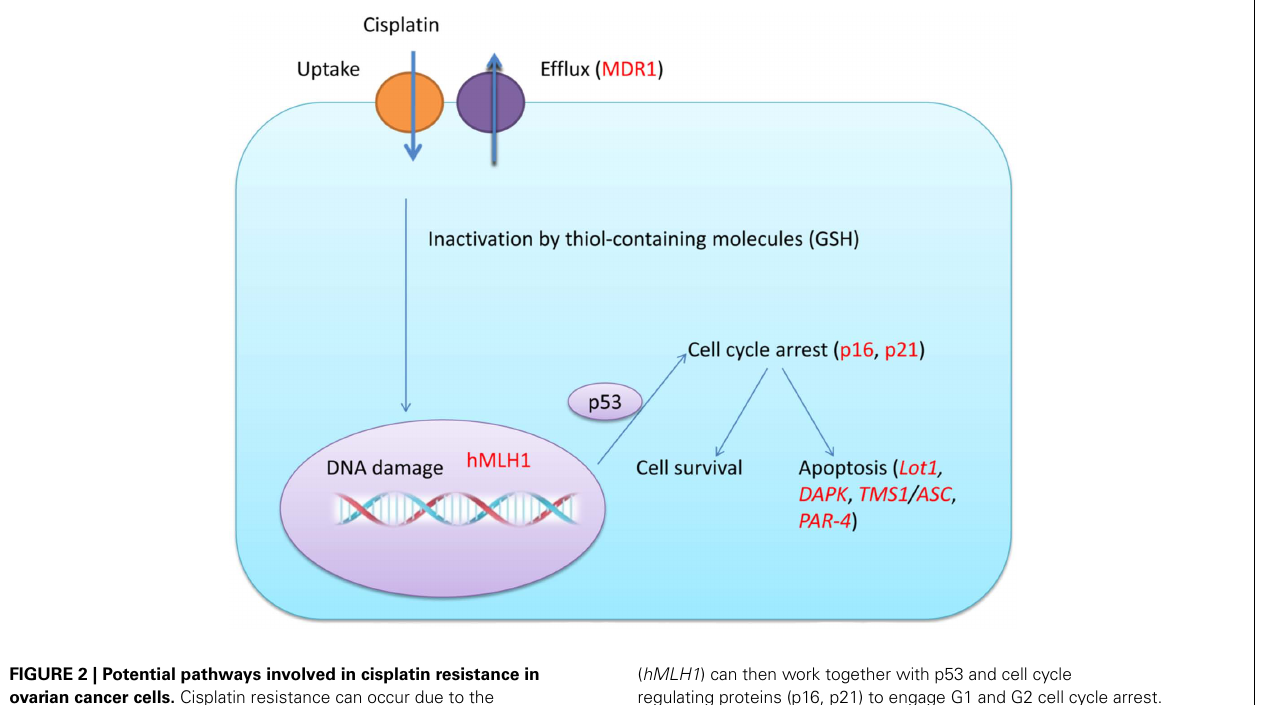
FIGURE 2 | Potential pathways involved in cisplatin resistance in ovarian cancer cells. Cisplatin resistance can occur due to the decrease of proteins that are responsible for its uptake and an increase of proteins that can transport cisplatin to the outside of a cell. Cisplatin in the cell can also be inactivated by thiol-containing molecules (GSH) and cisplatin could cause DNA damage.The DNA repair system